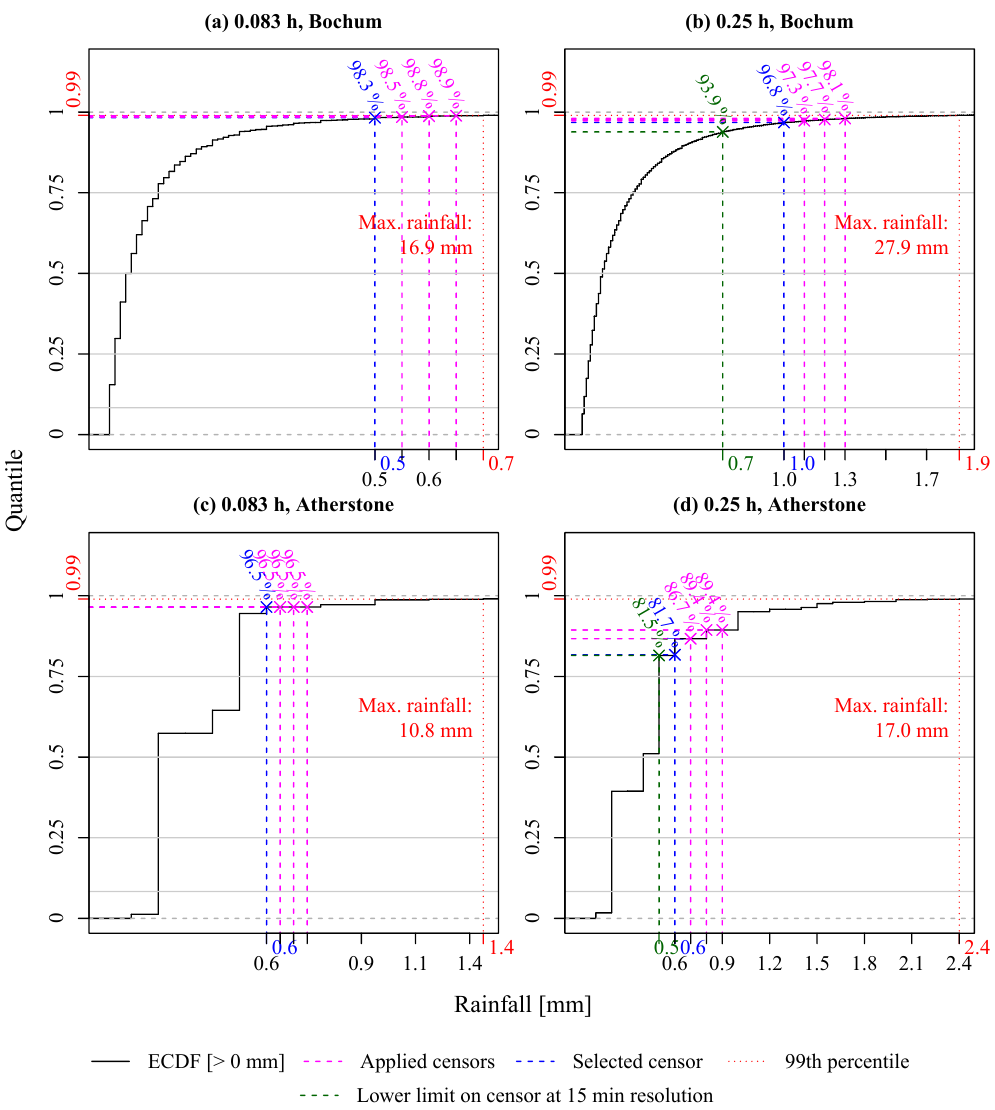
Figure 13. Empirical cumulative distribution function plots for Bochum and Atherstone rainfall aggregated to 5 and 15min temporal reso- lutions. The plots are limited to the 99th percentile rainfall and show the rainfall quantiles corresponding to the optimum censors used in the estimation of extremes in Figs.